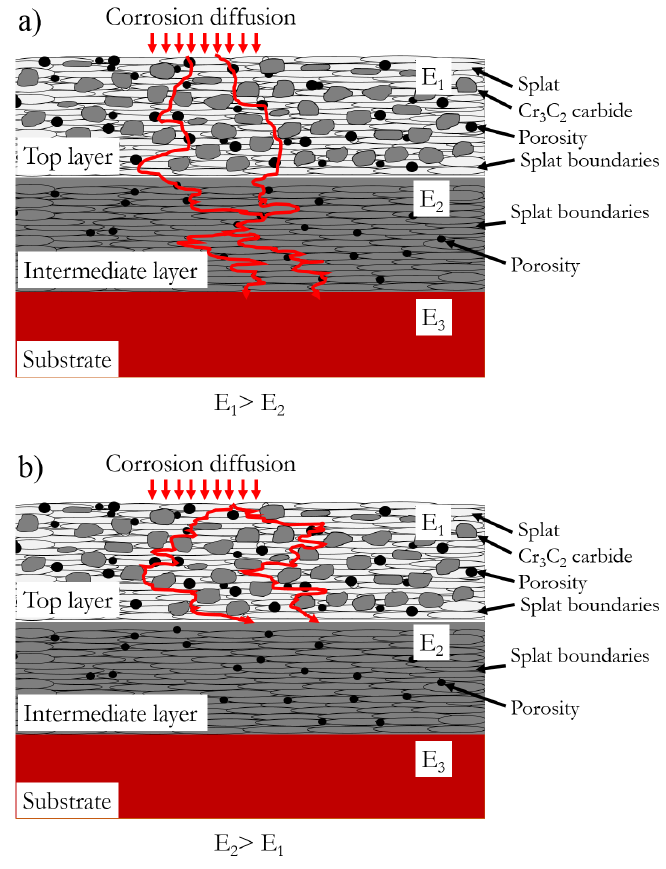
Figure 8. Schematic view of bilayer coatings with different configurations, ( a ) OCP of the top layer is higher than that of the intermediate layer, and ( b ) OCP of the intermediate layer is higher than OCP of the top layer. E 1 = corrosion potential of the top layer, E 2 = corrosion potential of the intermediate layer, and E 3 = corrosion potential of the substrate.